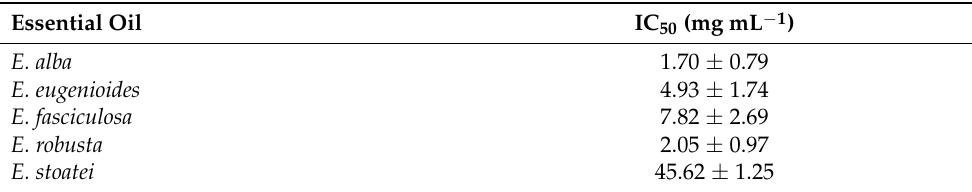
Table 3. Antioxidant activity of the EOs according to the DPPH assay. Data are expressed as the mean ± SD of three experiments.